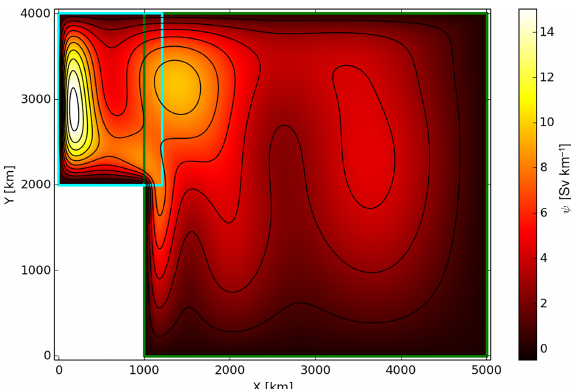
Figure 12. Stream function ψ for a nonrectangular domain run with QG on a composite domain. Plotted is ψ after 15 days of evolution with the composite QG code (Sect. 4.1.2) on a domain consisting of two coupled subdomains, indicated by the cyan and green rect- angles.